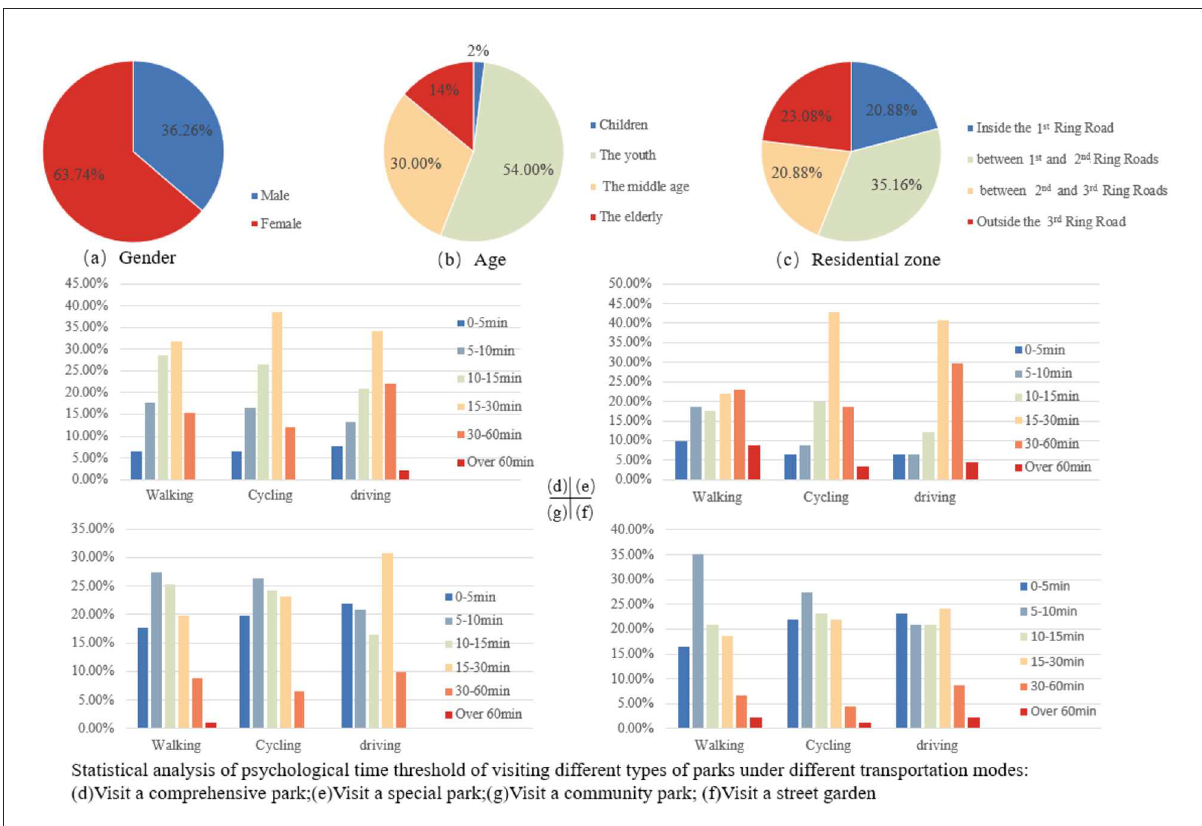
FIGURE7 Statistical analysis of questionnaire results.